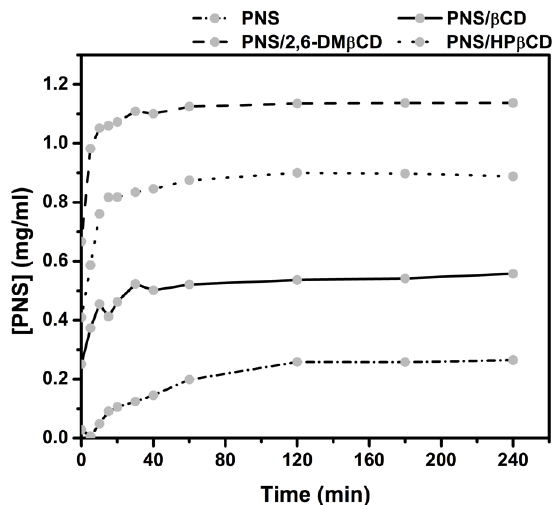
Figure 6. Dissolution diagrams of free PNS and its inclusion complexes with the three βCDs in water at 37 °C.